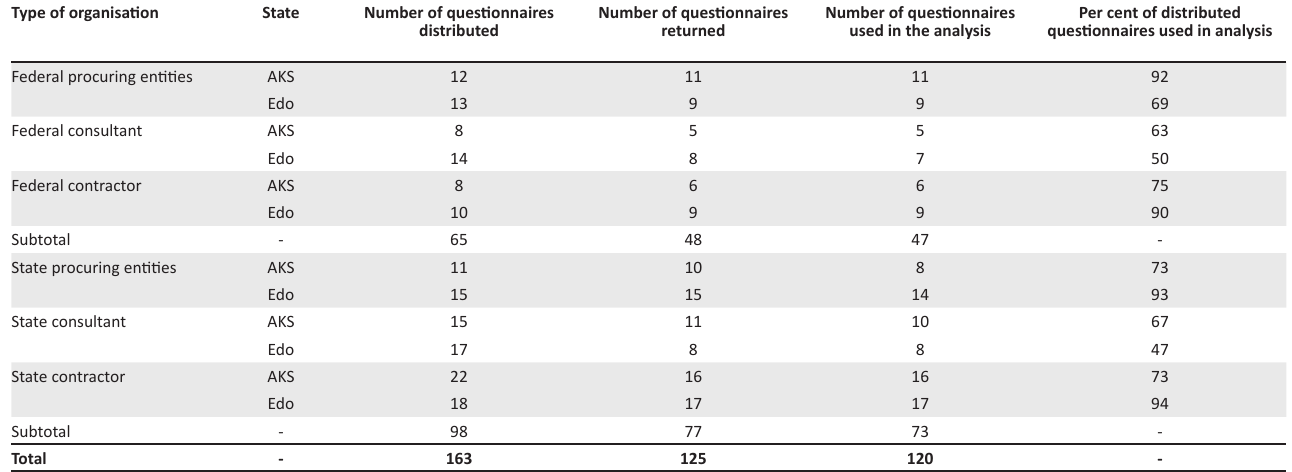
TABLE 2: Questionnaire distribution and